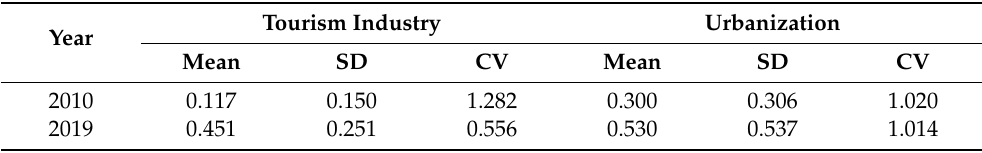
Table 4. The related statistics of tourism industry and urbanization levels in the mountainous border areas of western Yunnan.